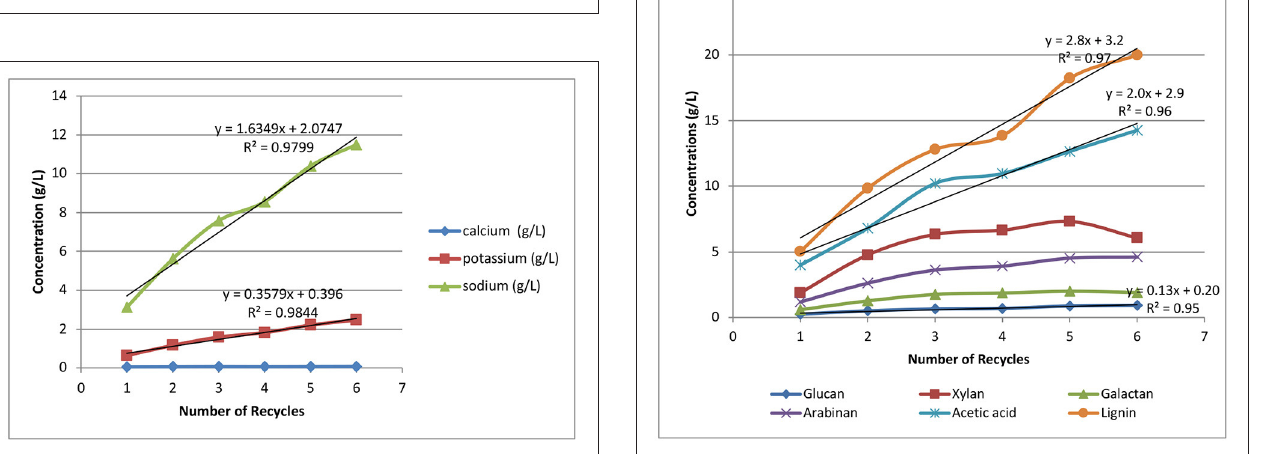
FIGURE 4 | Effect of number of recycling on soluble solids in the wash liquors.